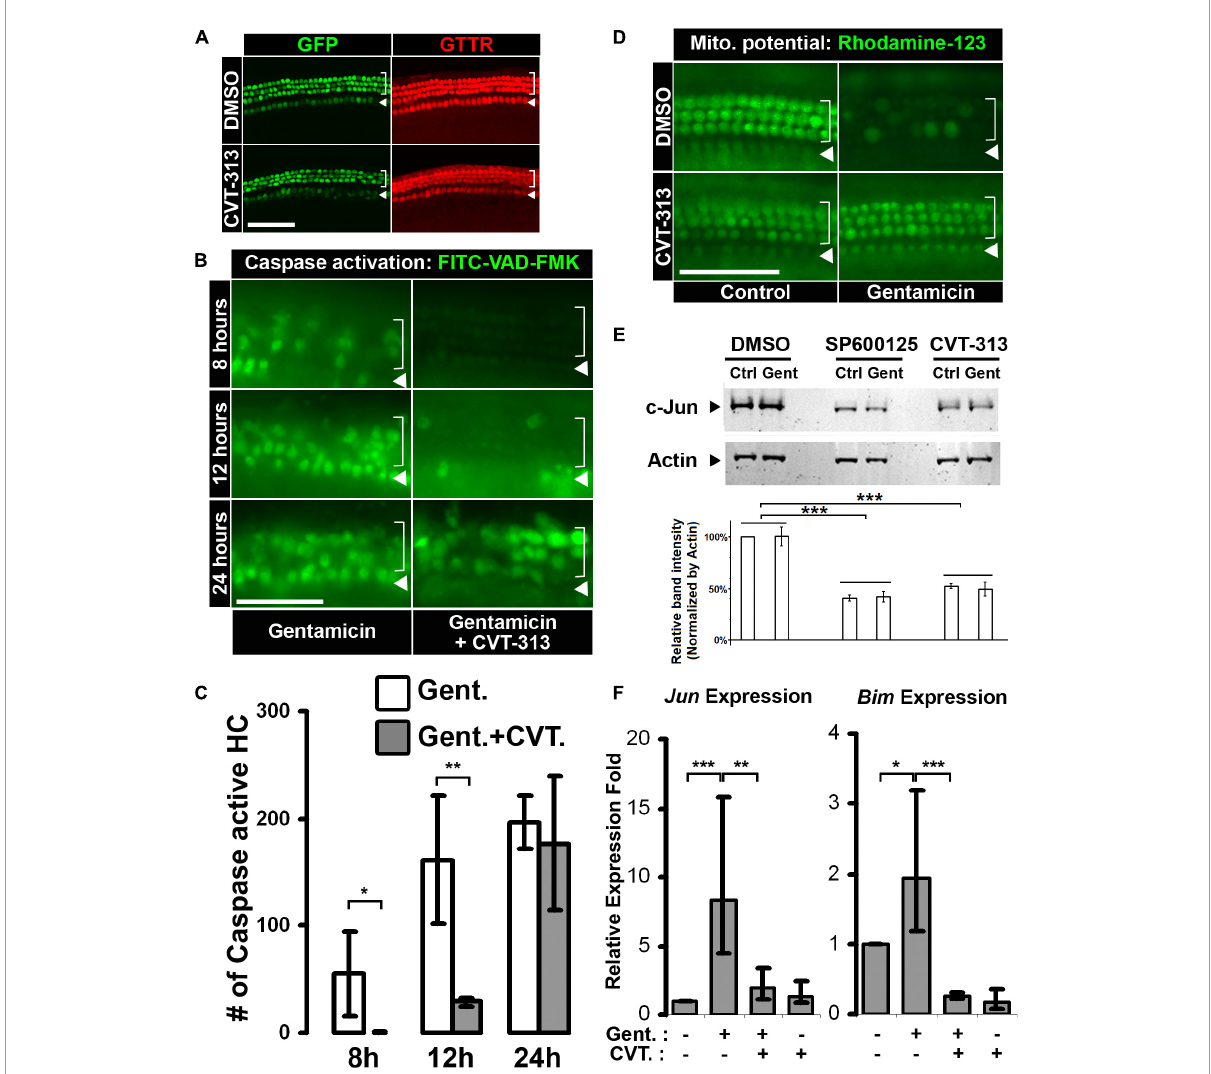
FIGURE3 Inhibition of CDK2 activity delays gentamicin-induced hair cell apoptosis through c-Jun activity suppression. (A) Hair cell specific uptake of gentamicin is not affected by CDK2 inhibition. GTTR accumulates specifically in hair cells in the absence or presence of CDK2 inhibitor CVT-313. (B) Inhibition of CDK2 by CVT-313 delays gentamicin-induced activation of caspase cascade. Representative images of the base of the cochleae (wild-type, no Atoh1-GFP transgene) at 8-, 12-, and 24-h are shown. Activation of Caspase is indicated by FITC fluorescence, and there are more FITC-positive hair cells in organs treated by gentamicin alone than organs treated by gentamicin and CVT-313 at 8- and 12-h. (C) Quantification of FITC-positive hair cells in the base of cochleae at 8-, 12-, and 24-h timepoints. p = 0.076 for 8-h; p = 0.018 for 12-h; p = 0.64 for 24-h; n = 3. (D) Inhibition of CDK2 activity by CVT-313 preserves mitochondrial membrane potential in hair cells after gentamicin treatment. Representative pictures of the base of cochleae (wild-type, no Atoh1-GFP transgene) at 6-h are shown. Fluorescence of Rhodamine-123 indicates the existence of potential difference across the mitochondrial membrane. Gentamicin alone induces the loss of mitochondrial membrane potential in hair cells, while the presence of CVT-313 preserves the potential at 6-h. (E) Inhibition of CDK2 by CVT-313 reduces c-Jun protein in the whole organ of cochlea, shown by western blotting. No differences were detected between untreated (Ctrl) and gentamicin-treated (Gent) organs; but JNK inhibitor SP600125 and CDK2 inhibitor CVT-313 reduce c-Jun level significantly. Actin is used as loading control. The band intensities were measured by LI-COR Image Studio and normalized with Actin bands. ***Adjusted- p < 0.001, n = 3. (F) Quantitative-PCR showing gentamicin-induced Jun and Bim expression in hair cells are suppressed by CDK2 inhibitor CVT-313. * p < 0.1; ** p < 0.05; *** p < 0.01. For images of surface preps, inner hair cells are indicated by arrowhead and outer hair cells are indicated by bracket. All surface prep images were taken from the base of the cochleae. Scale bar, 50 µ m. Error bars in quantification plots indicate standard